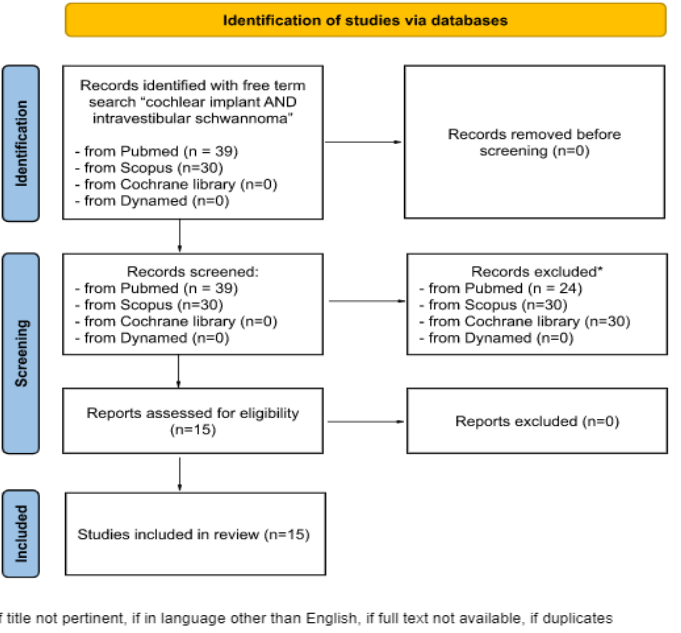
Figure 1. PRISMA flow diagram for the literature research on Pubmed, Scopus, Cochrane Library and Dynamed, up to December 2022. and Dynamed, up to December